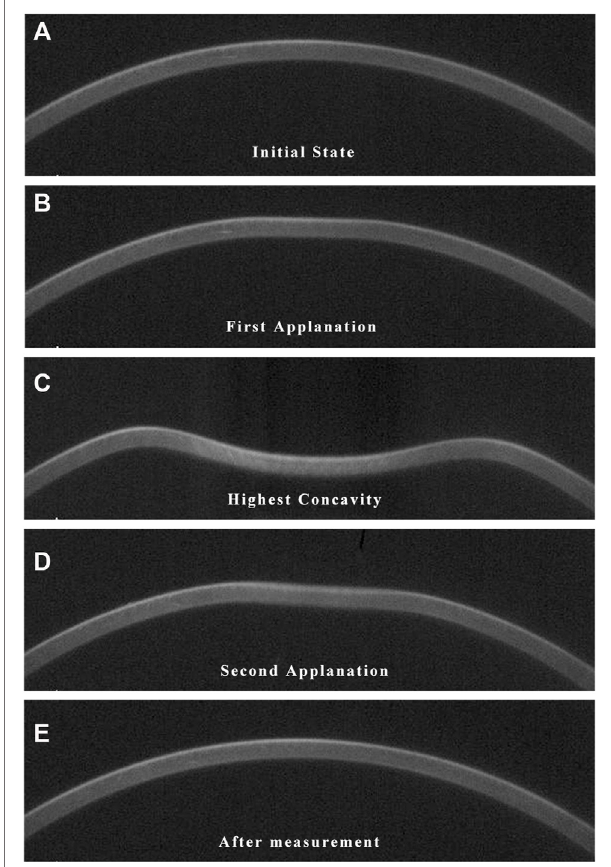
FIGURE1 | Images of corneal deformation during CorVis ST measurement. When applied by an air pulse, the cornea inwards into a concavity state and fi nally returns to its original shape through the following phases. (A) The initial convex state. (B) The fi rst applanation. (C) The highest concavity. (D) The second applanation. (E) The fi nal convex